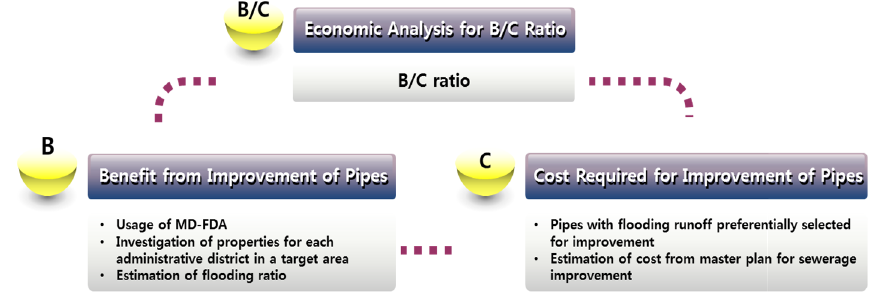
Figure 9. Sections with insufficient capacity. ( a ) Future I (2020s); ( b ) Future II (2050s); ( c ) Future III (2080s).